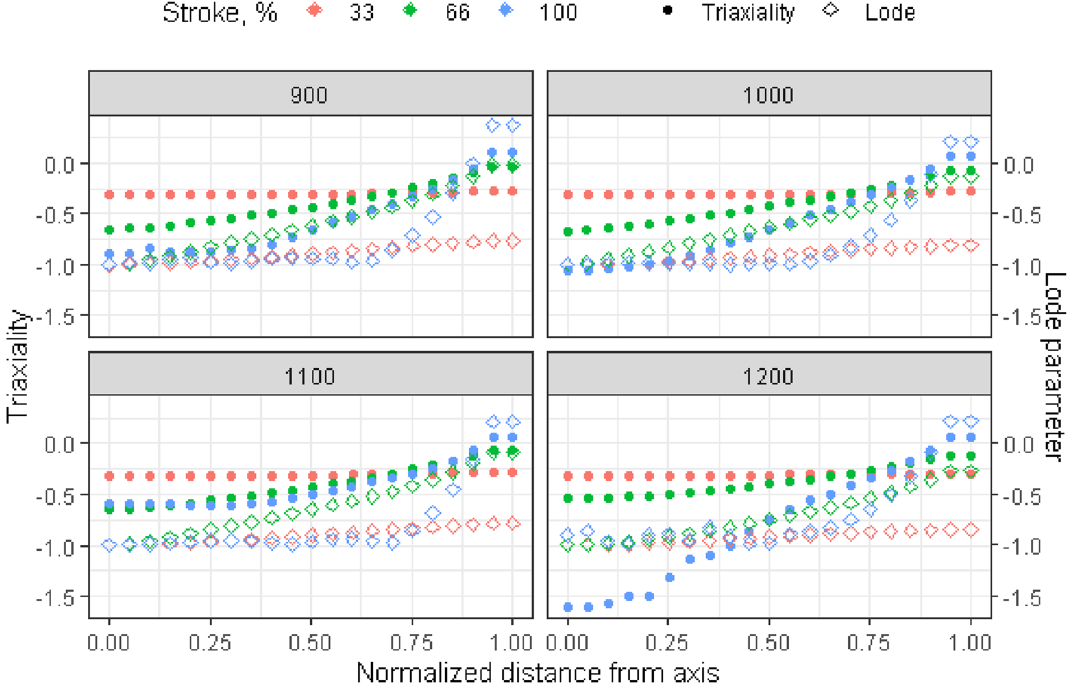
Fig. 12 Lode parameter and triaxiality factor for the equator line in three compression stages for a nominal strain rate of 15